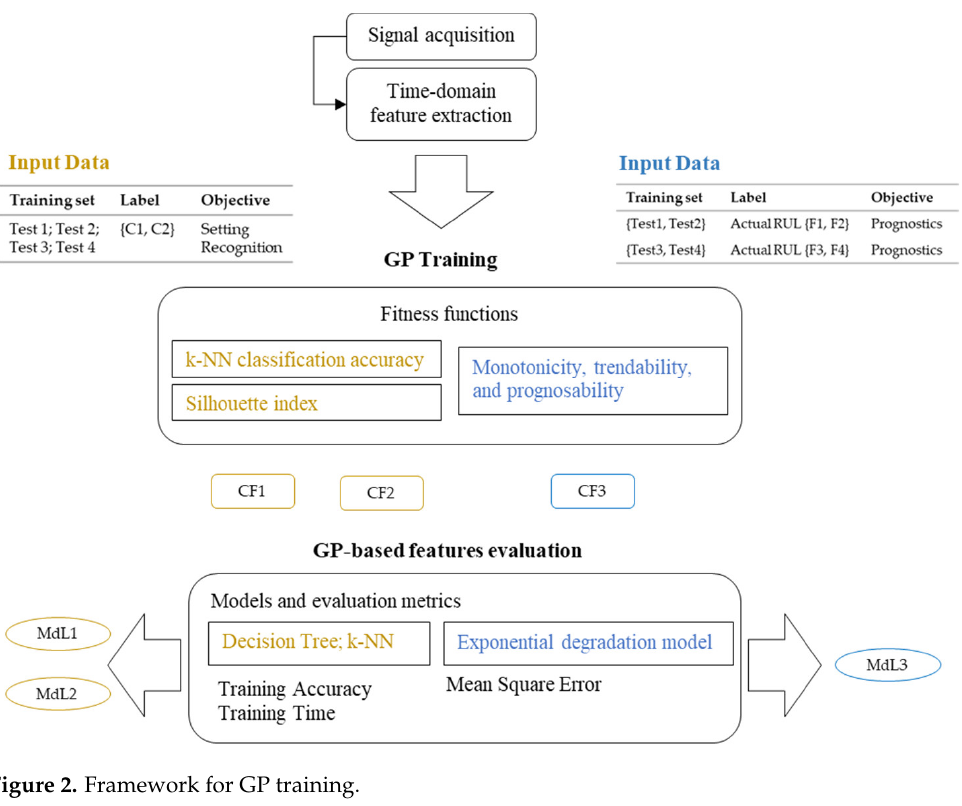
Figure 2. Framework for GP training.